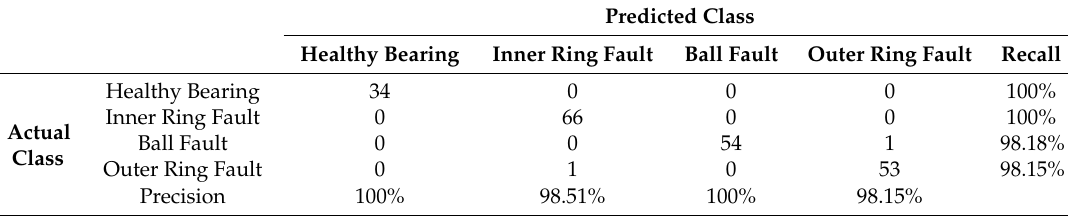
Table 11. Classification rate for Cooperative GA- neural network based Fault Diagnosis (Test